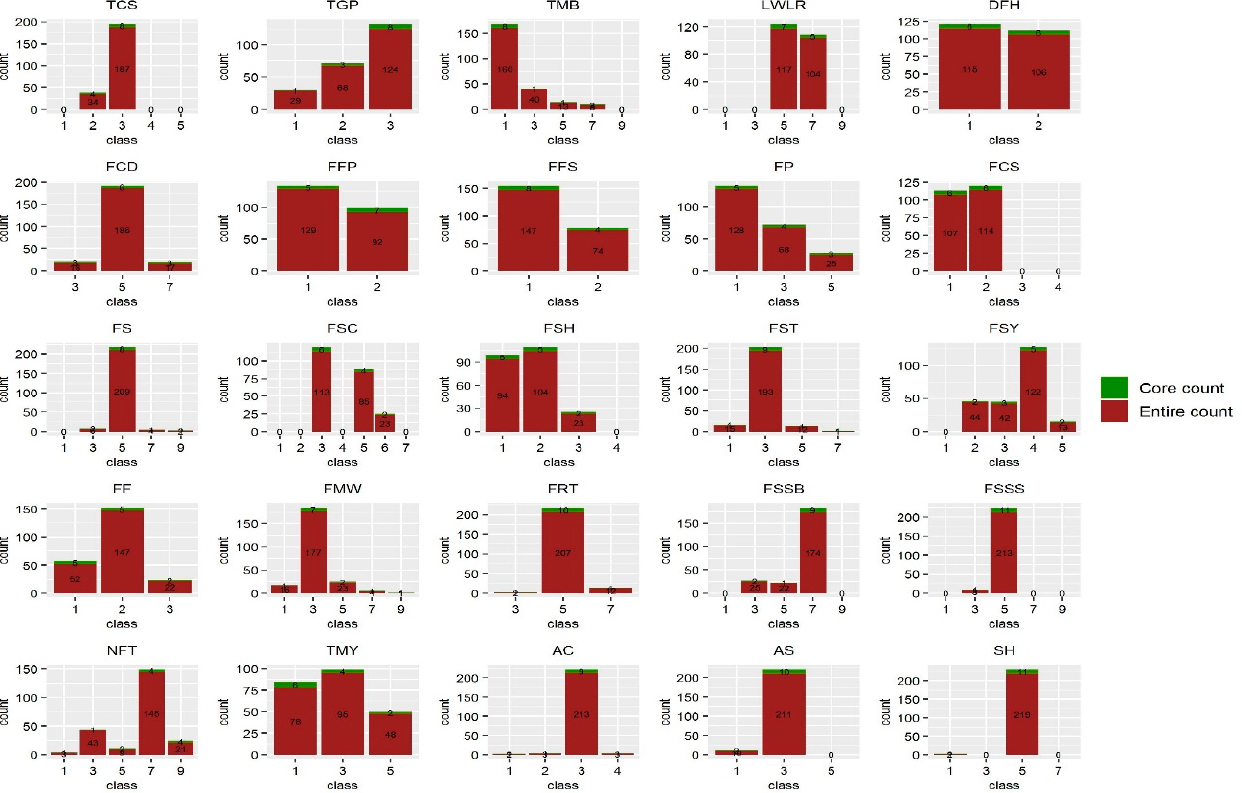
Figure 8. Frequency distribution of evaluated pomegranate genotypes in primary and core collections.